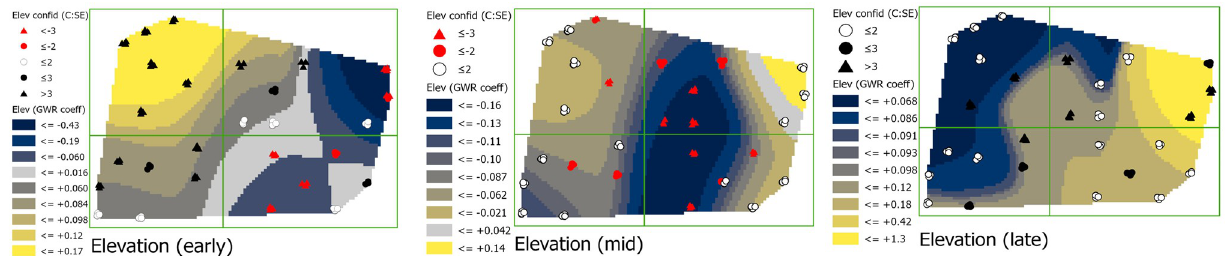
Fig 5. Maps showing early, mid-, and late season elevation (ELEV) coefficients with estimations of credence in coefficient values. Coefficient surface values were symbolized using a geometric interval classification scheme from blue to gold, with grey indicating the interval including zero (if present).